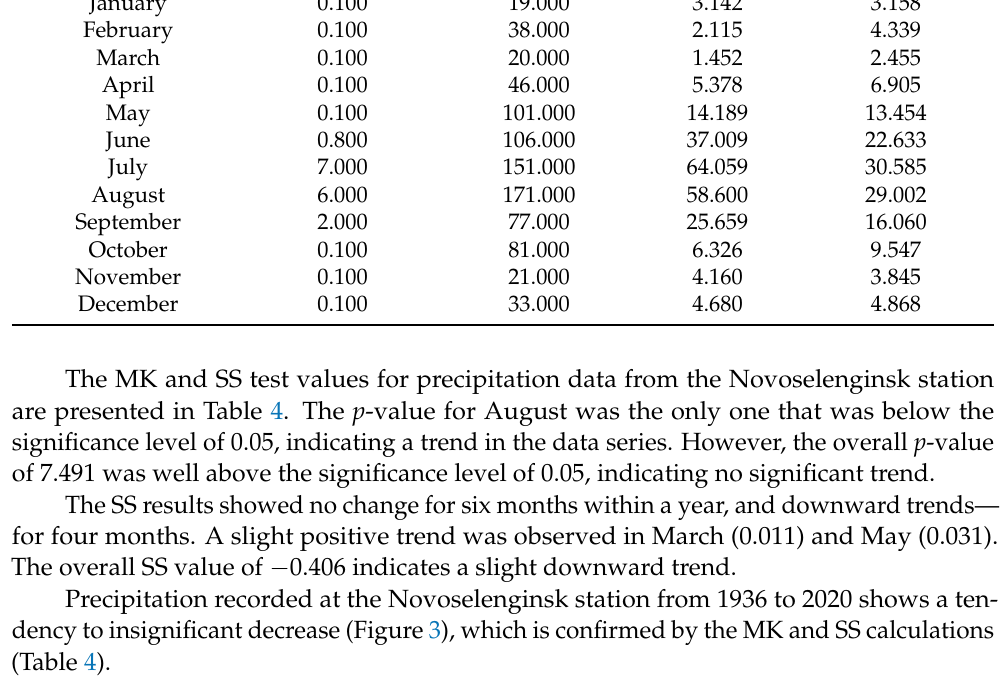
Figure 2. Rainfall trend at the Kyakhta station for the period of 1936–2021.